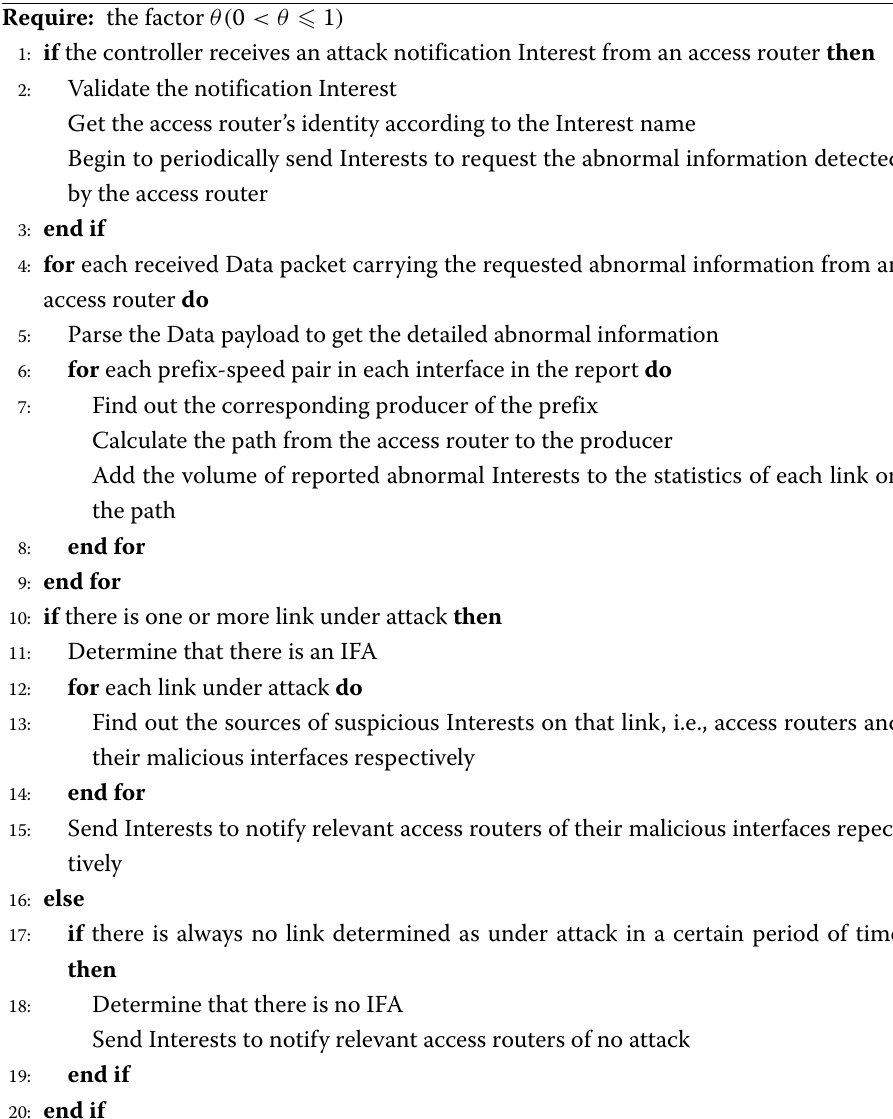
Algorithm 2 Process of attack detection and mitigation at the central